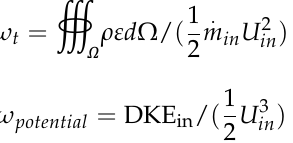
Figure 18. Comparison of the DKE decay. The interface is used as the starting position in the detailed loss analysis. At every condition, 𝜔 𝑝𝑜𝑡𝑒𝑛𝑡𝑖𝑎𝑙 of “far” is more extensive, and the difference is 0.0014, 0.0006, and 0.0010, respectively, which is small enough to be ignored, and thus the detailed loss com ‐ parison is reasonable. As illustrated in Figure 19, the total loss of “far” is more extensive in every case where the loss in the spacing contributes the most. As load increases, the proportion of the loss in the spacing decreases, although the increased stator load will aggravate the wake mixing in the gap, showing that the wake’s reduced velocity deficit has the greatest impact on the loss in the spacing. The loss in the boundary layer between the two spacing is not apparent under the same conditions, indicating that the interaction between wake and boundary layer has a minor effect on the loss. The DKE at the stator LE of “far” can be almost ignored, and the loss difference in the freestream can